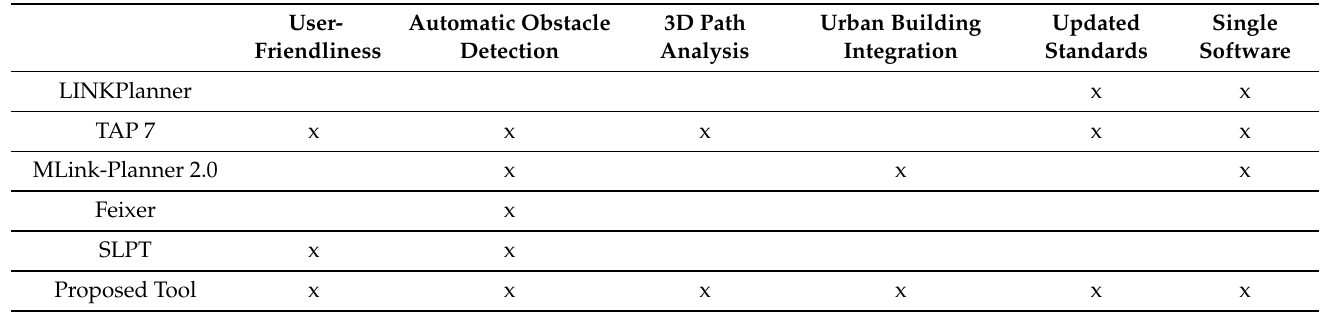
Table 1. Comparison of the researched tools and the developed tool in this